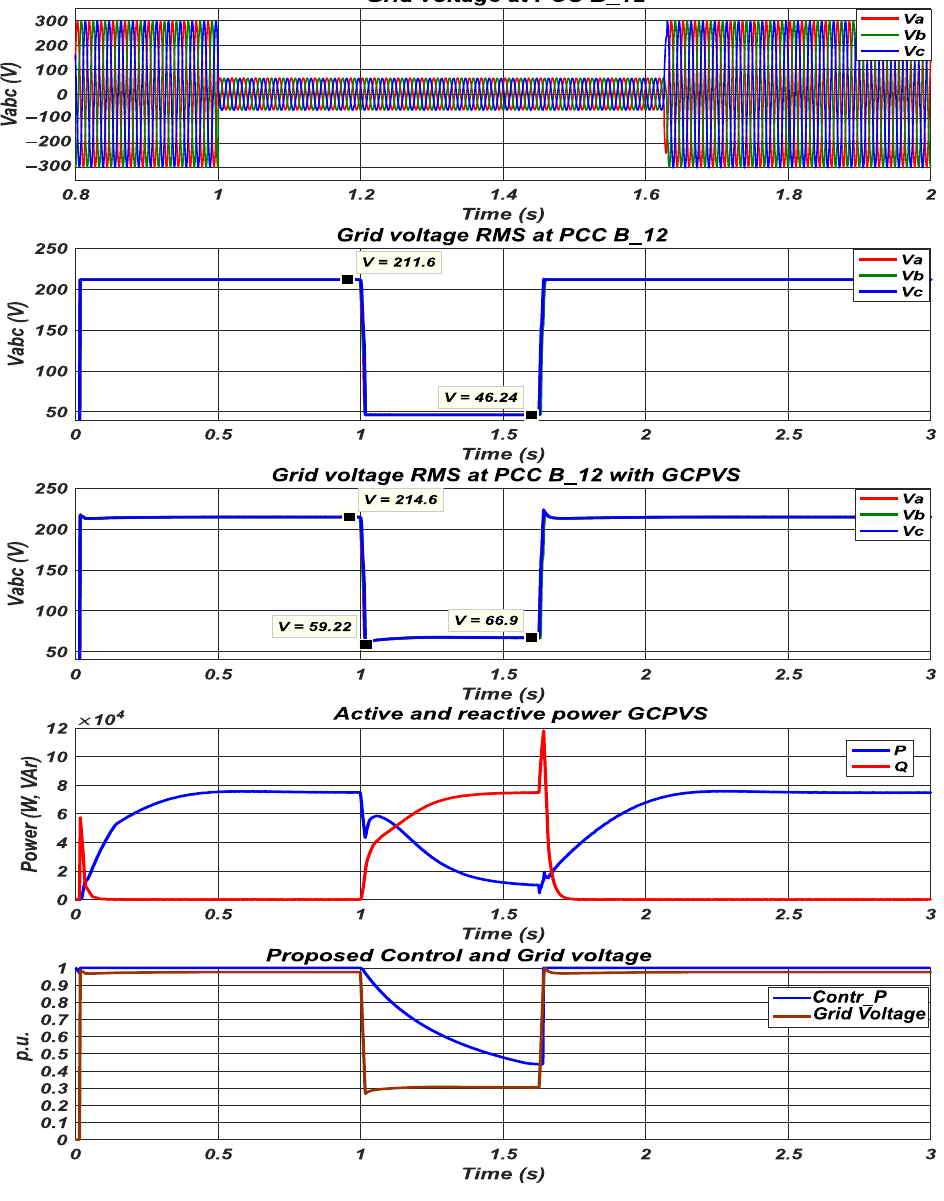
Figure 16. Simulation results of the GCPVS proposed for SDVV/MVD: symmetric three-phase short-circuit for 625 ms, with proposed control action.